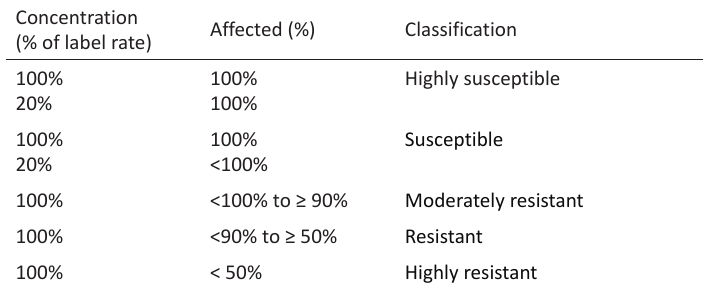
Table 4. IRAC classification for pyrethroids according to IRAC No 011 (IRAC